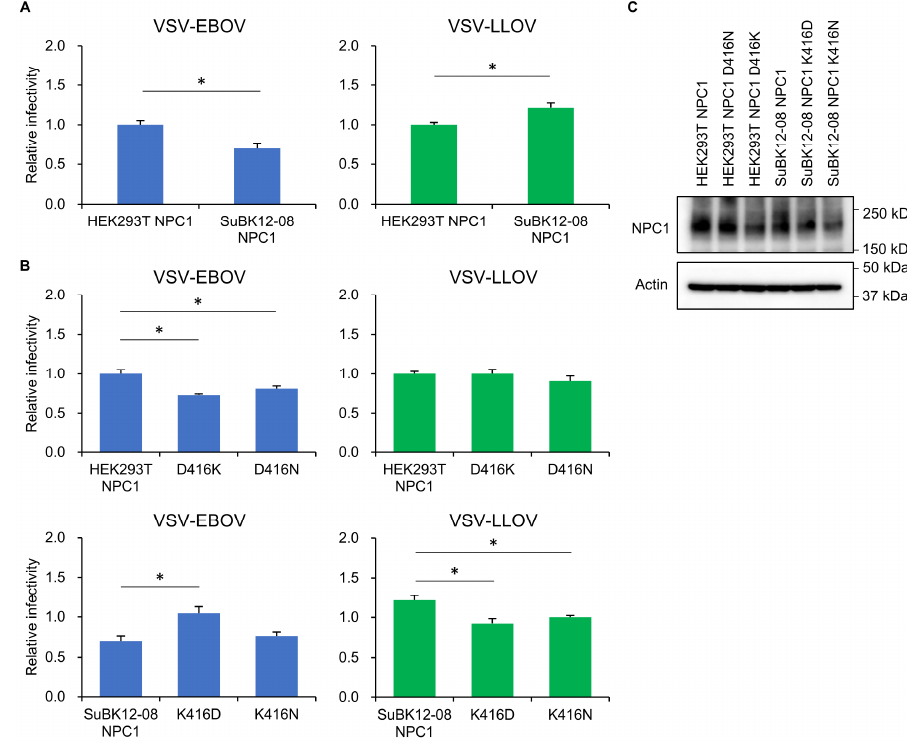
Figure 3. Effect of amino acid substitutions in the NPC1-C on cell susceptibility to pseudotyped VSVs. ( A and B ) Vero E6/NPC1-KO cl.19 cells transduced with exogenous NPC1 genes were infected with